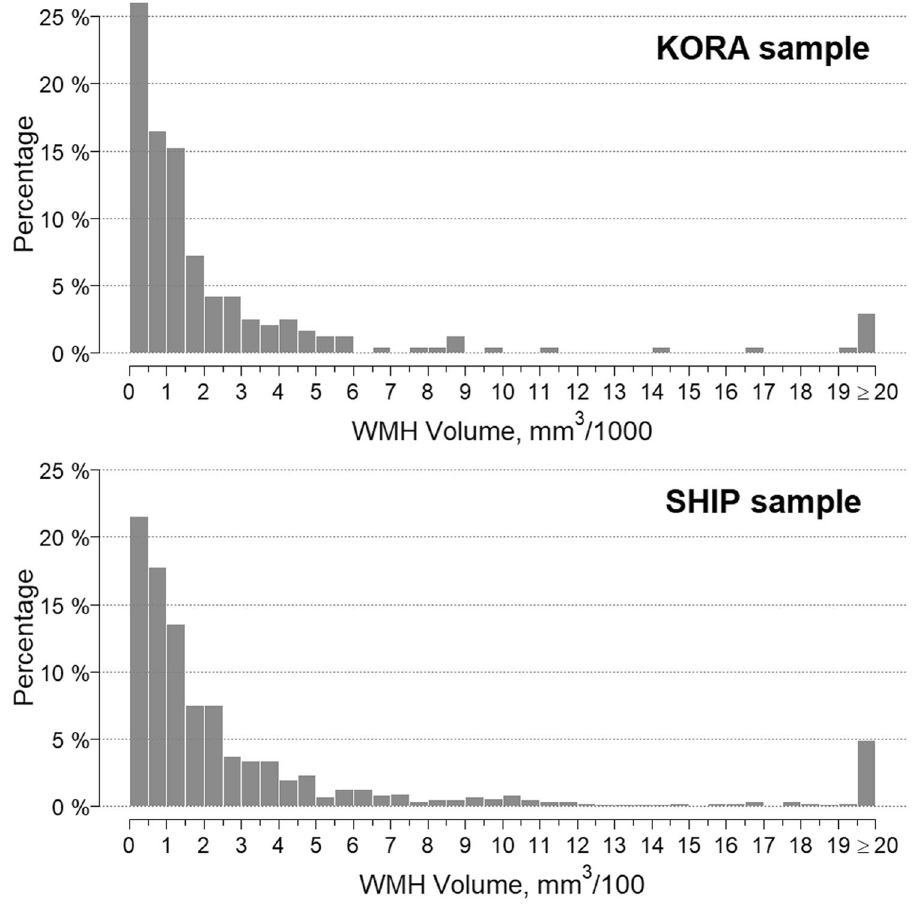
Figure 3. Categorised distribution of WMH volume in the KORA sample and SHIP sample. Mean WMH volume was 2798 ± 7392 mm 3 (median: 997 mm 3 ) in KORA and 532.4 ± 1750.0 mm 3 (median 135.5 mm 3 ) in SHIP. Possible explanations for this discrepancy in WMH volume are different measurement methods and different study collectives. Note that for elastic net regression, data was modelled continuously and not categorised.